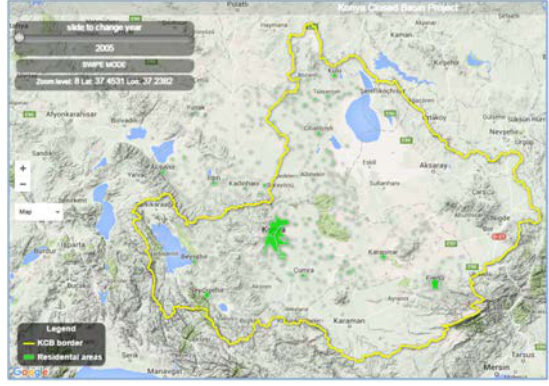
Figure 1. Study Area: Konya Closed Basin Border and Residential